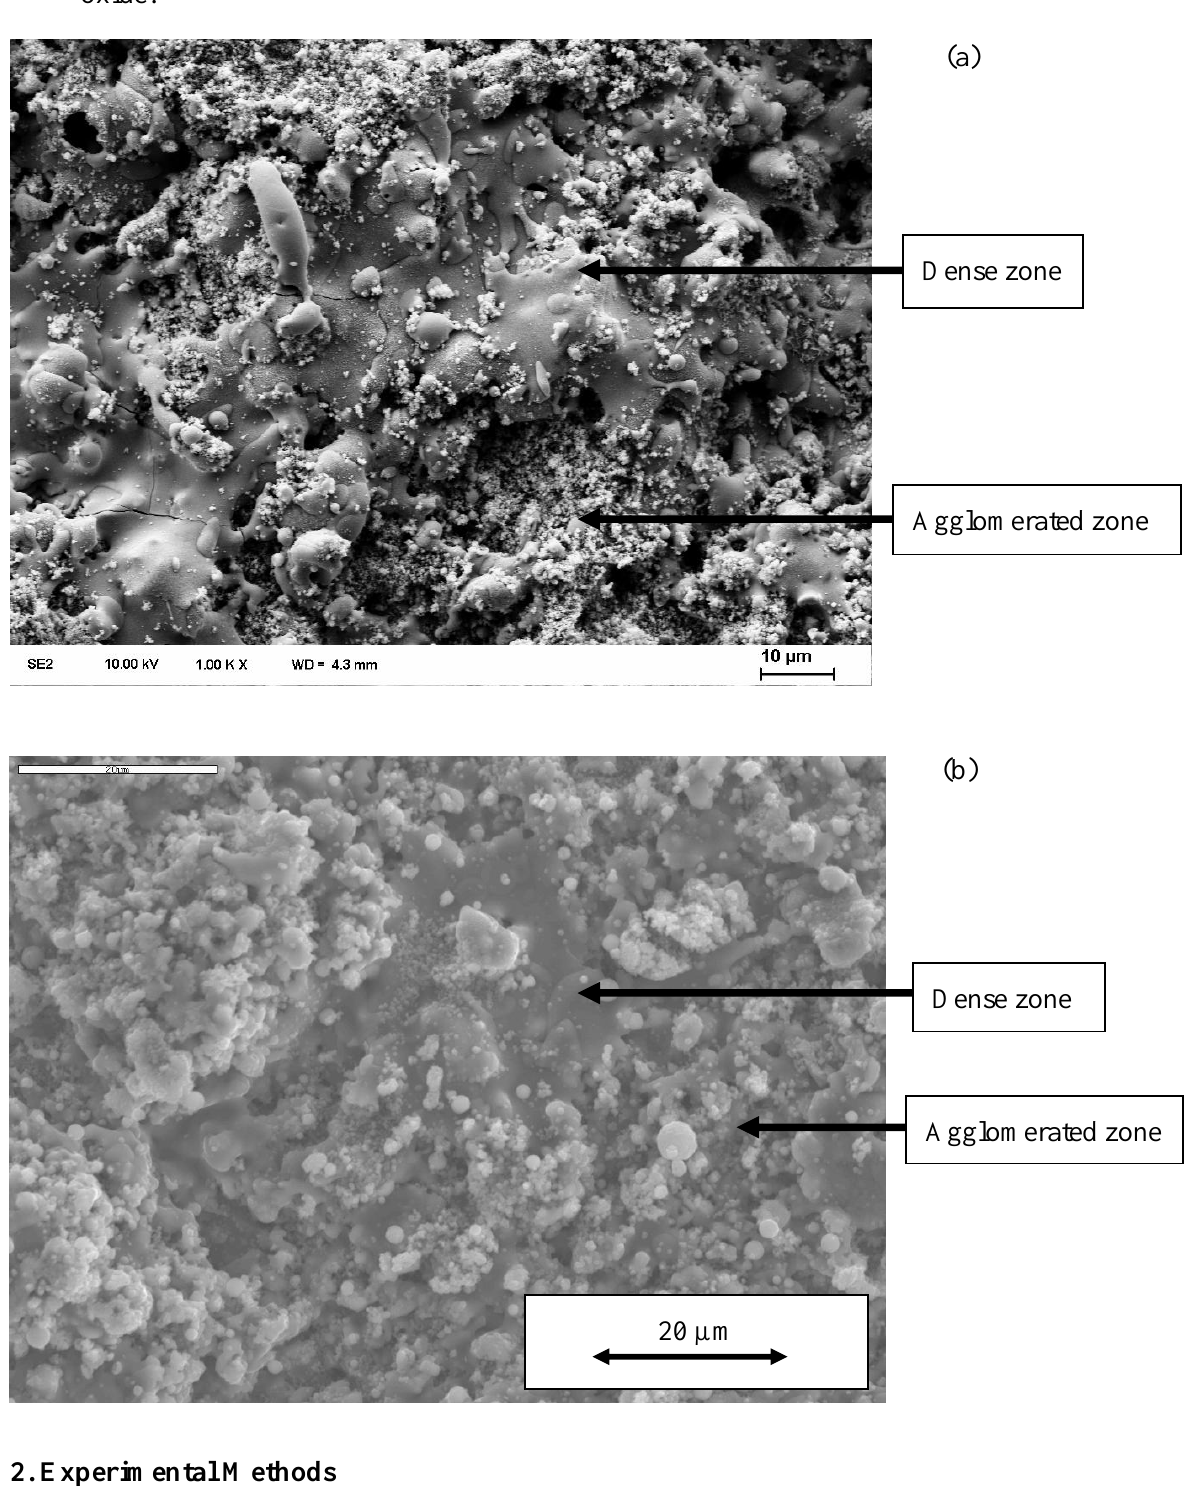
Figure 2. SEM (secondary electrons) micrographs of the coatings suspension plasma sprayed using internal, radial continuous-stream injector (a) hydroxyapatite (b) titanium